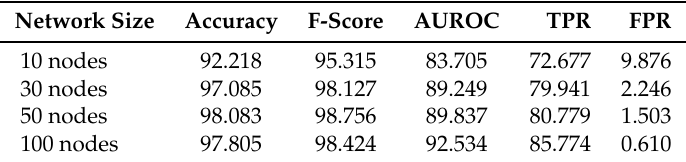
Table 3. Host-based detection performance per network size. (Max speed of 4.3